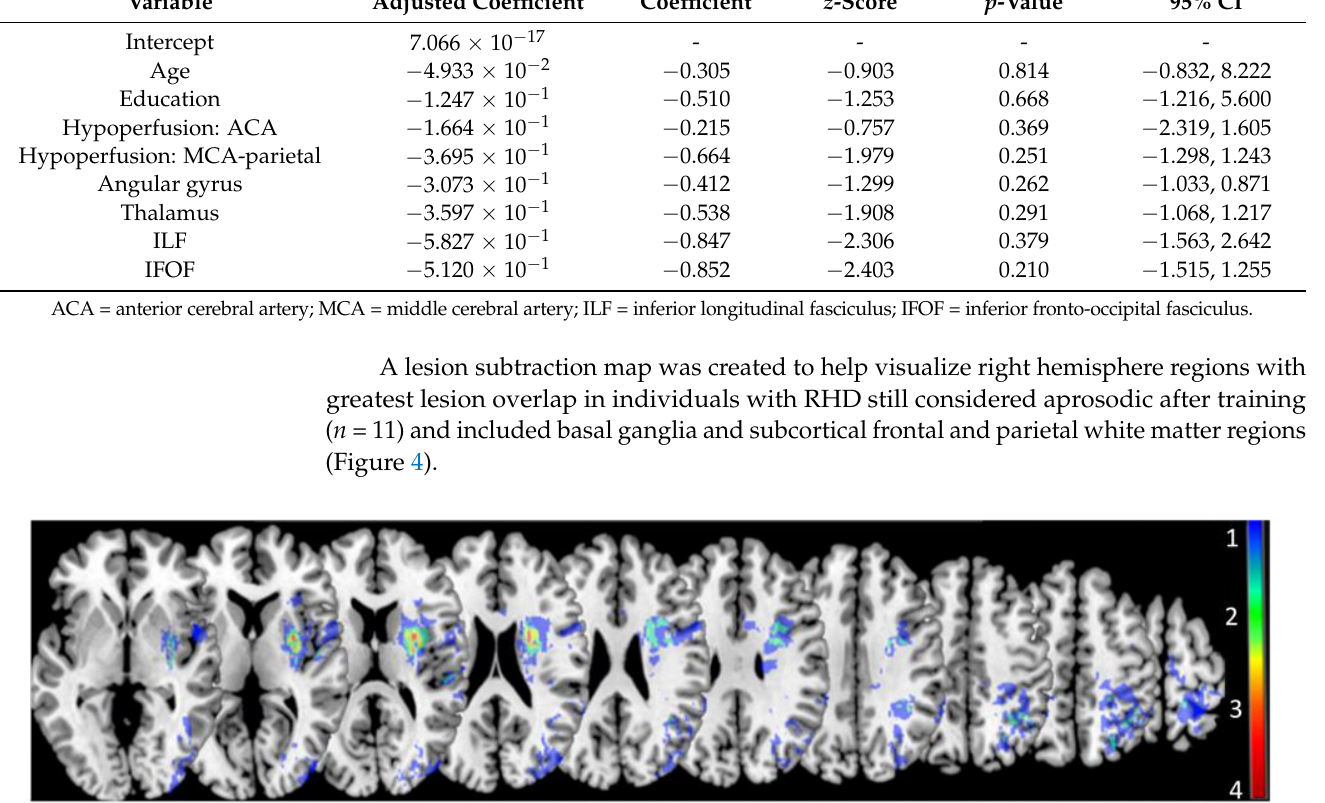
Figure 4. Lesion subtraction map of participants with RHD who were still considered aprosodic after acoustic-prosodic-emotion training. Color gradient scale on the right side of the image indicates the number of participants with overlapping lesions.